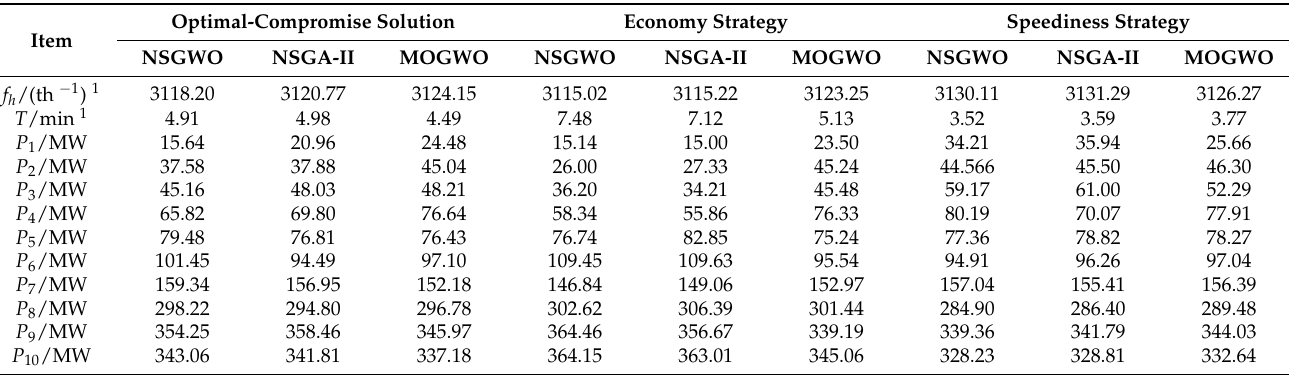
Table 9. Optimization results of load dispatch under economy and speediness strategies for 10 units of various power